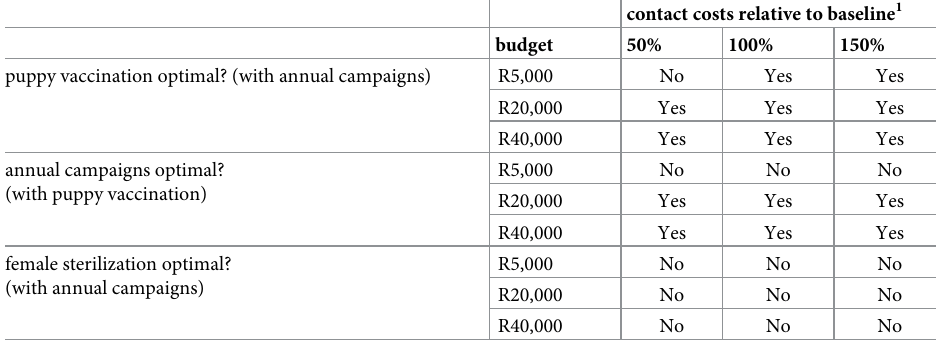
Table 6. Sensitivity of results to alternative contact costs.